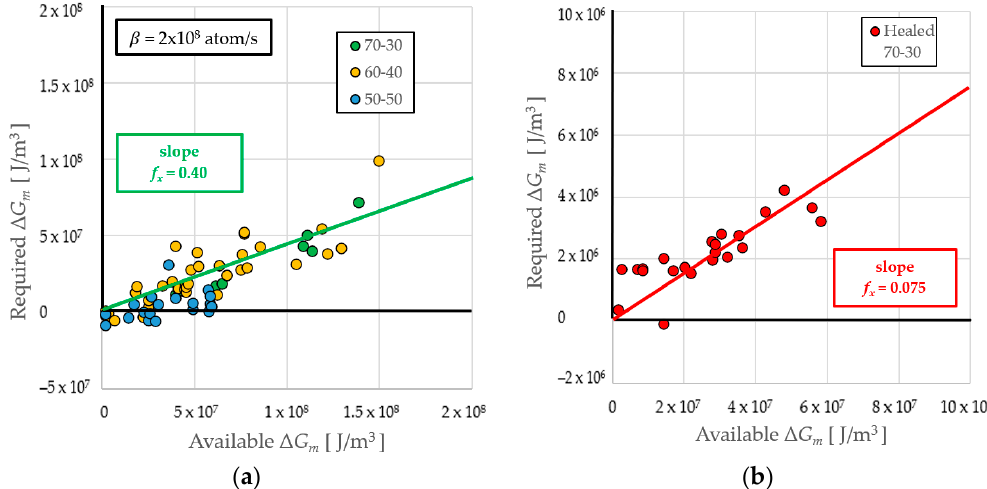
Figure 4. Evaluation of the retained energy parameter from a plot of required to available retained free energy. ( a ) Data for all alloys at delays τ < 1 s; ( b ) data for healed Fe 70 Co 30 at delays τ > 1 s.